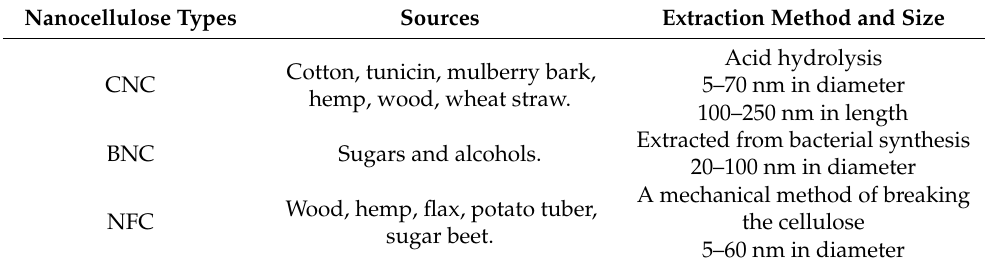
Table 1. Types of nanocellulose